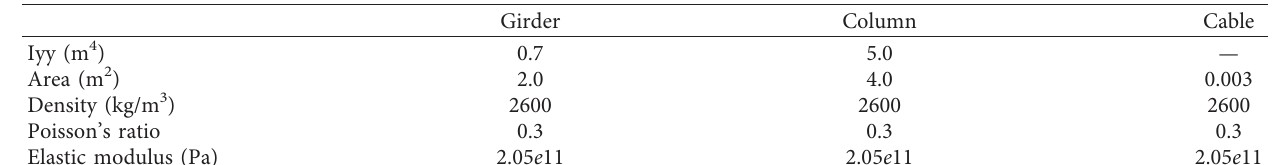
Figure 4: Layout of the simple cable-stayed Table 1: Parameter of the simple cable-stayed bridge.